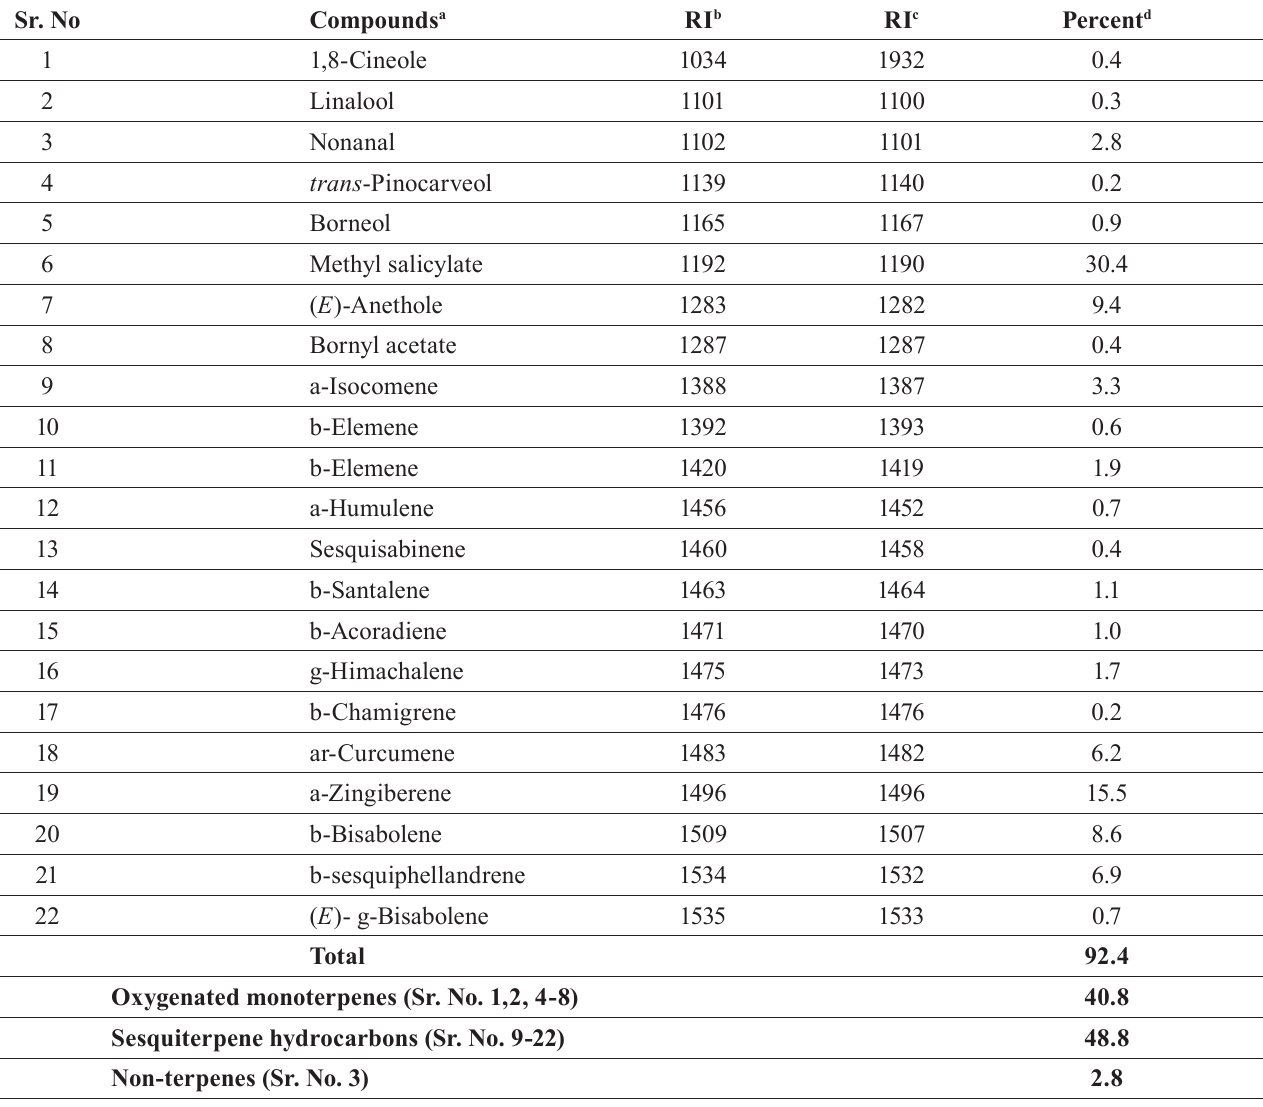
a Order of elution on HP-5 column; b Retention indices on HP-5 column; c Literature retention indices (see Experimental); d Standard deviation were insignificant and excluded from the Table to avoid congestion; Sr. No, serial number